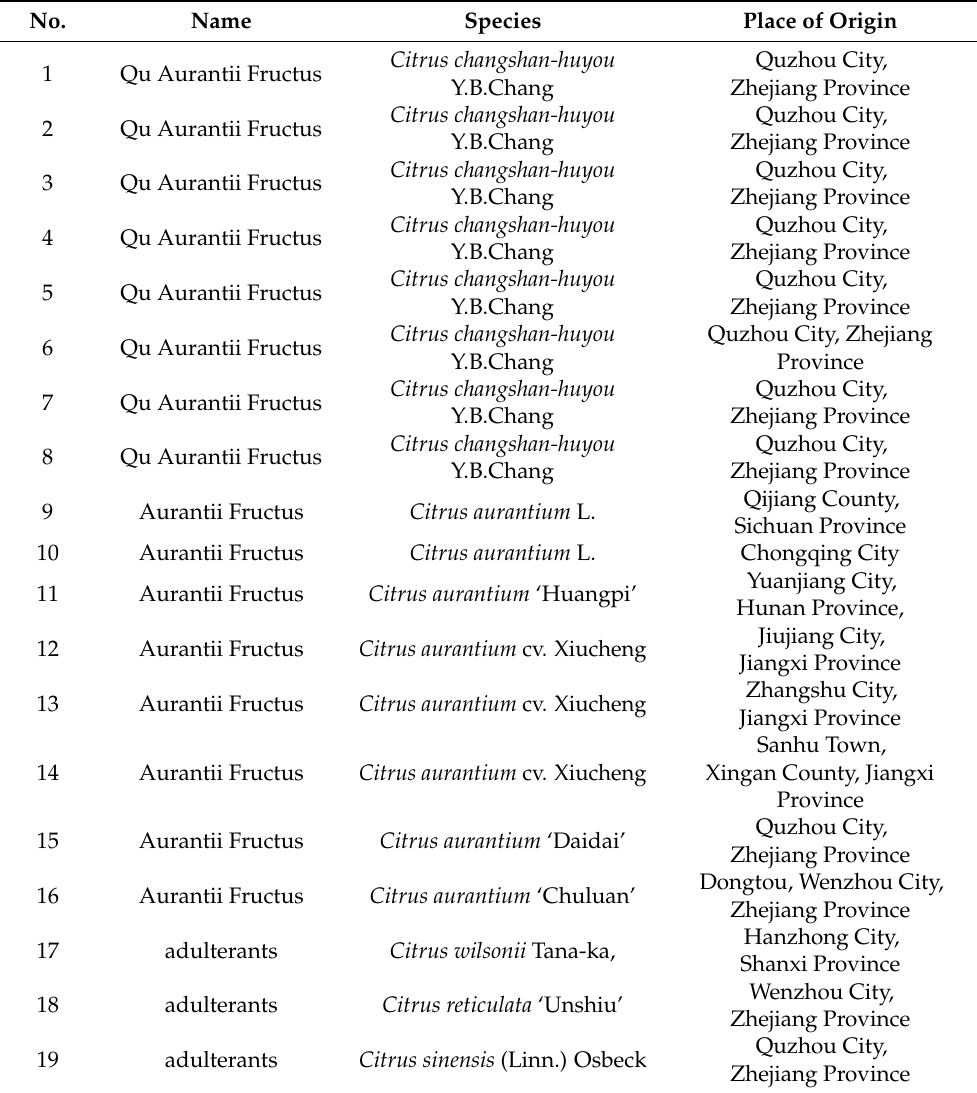
Table 2. Sample information